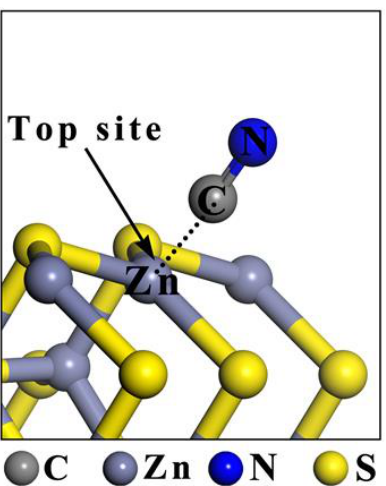
Figure 2. CN − top-site adsorption on the surface of sphalerite (110). When zinc sulfate is used in combination with cyanide, cyanide can form a complex with zinc ions. The reaction equation is expressed as Equation (1): Zinc sulfate can undergo ionization and hydrolysis reactions in aqueous solution by Equations (2) and (3): And Therefore, the main coordination products of zinc sulfate and cyanide are Zn(CN) 2 and Zn(OH) 2 , as shown in Figure